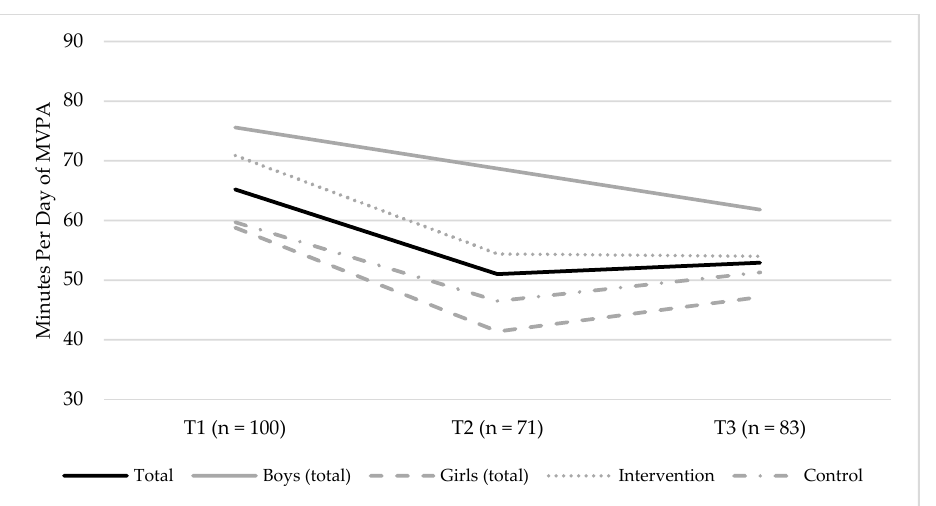
Figure 1. Changes in minutes per day of the accelerometer-measured moderate-to-vigorous physical activity (MVPA), between T1 (baseline, 2014) and T3 (endpoint, 2016), for the total sample, boys (total sample), and girls (total sample), and the intervention and control groups, respectively. The figure shows the mean group level of MVPA.